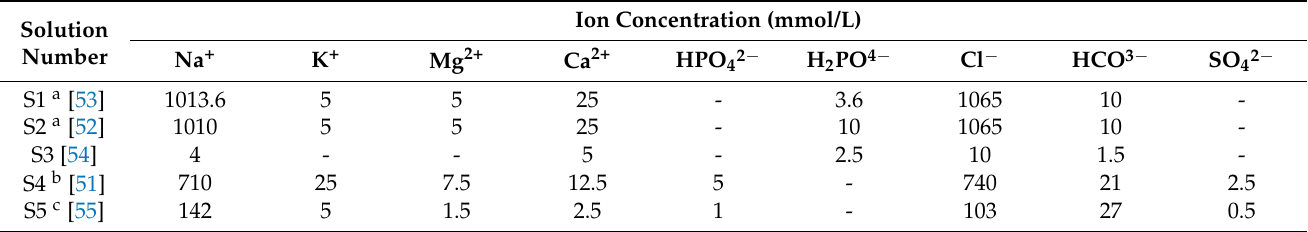
Table 1. The ion concentrations of prepared coating solutions with the corresponding